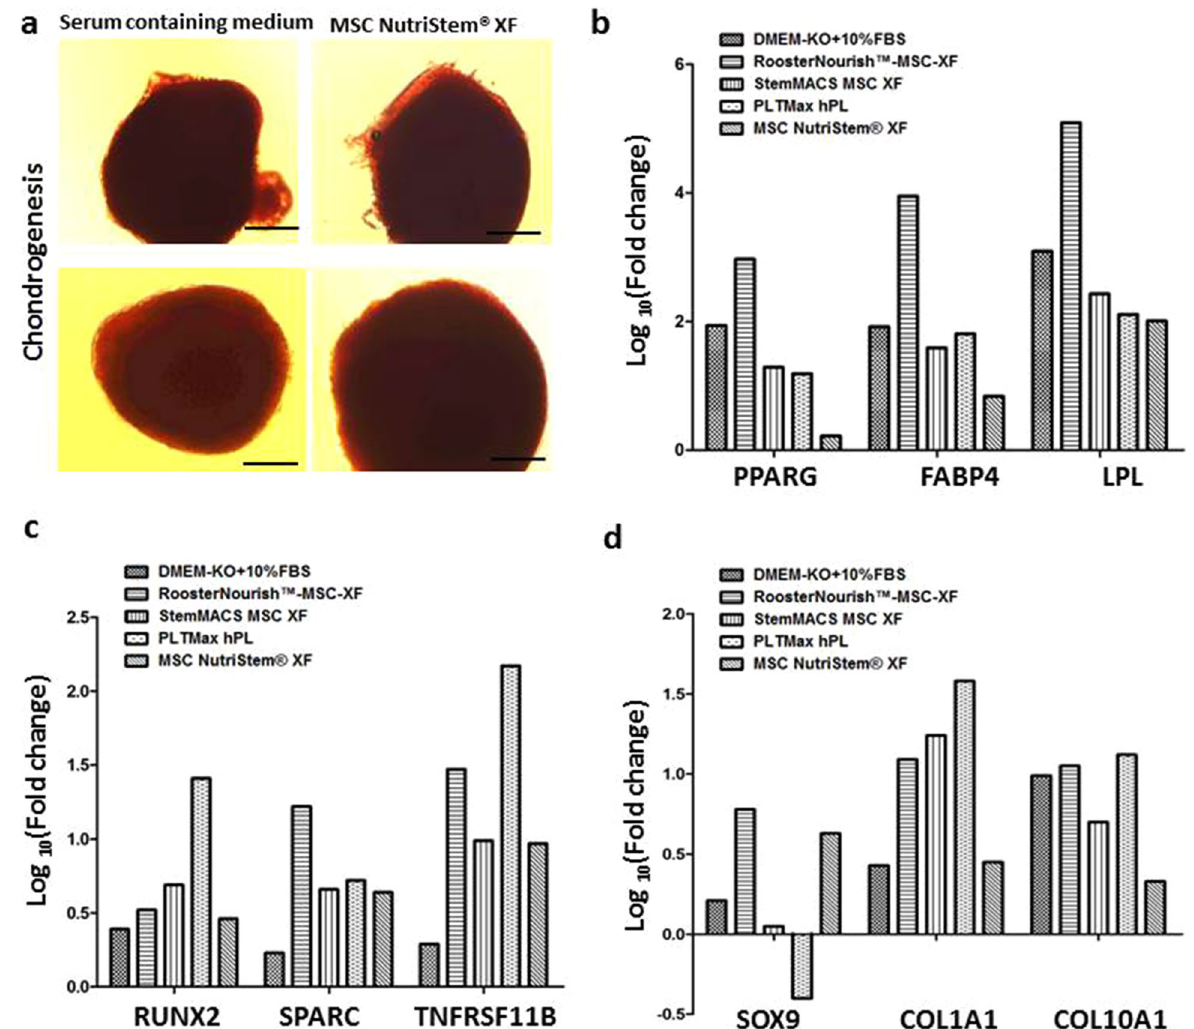
Figure 7. Chondrogenic differentiation and quantification of gene expression in the adipogenic, osteogenic and chondrogenic differentiated cells cultured in SFM/XFM and control medium. ( a ) Chondrogenic differentiation of BM-MSCs in MSC Nutristem XF in 96 well V- bottom plates as evident by 1% Safranin O staining. BM-MSCs cultured in serum containing medium was used as control. The images were captured at 10X magnification with scale bar of ∼ 100 μm. ( b ) Bar graph showing the fold change in the mRNA expression of PPARG , FABP4 and LPL genes in adipogenically differentiated cells relative to the uninduced control (undifferentiated) by real time PCR analysis. ( c ) Bar graph depicts the fold change in the mRNA expression of RUNX2 , SPARC and TNFRSF11B genes in osteogenically differentiated cells relative to the uninduced control (undifferentiated). ( d ) Bar graph showing the fold change in the mRNA expression of SOX9 , COL1A1 and COL10A1 genes in chondrogenically differentiated cells relative to the uninduced control (undifferentiated). The Y axis is represented as log 10 fold change. The log 10 fold change of uninduced controls is zero. The expression of these genes varied with one another among each of the media